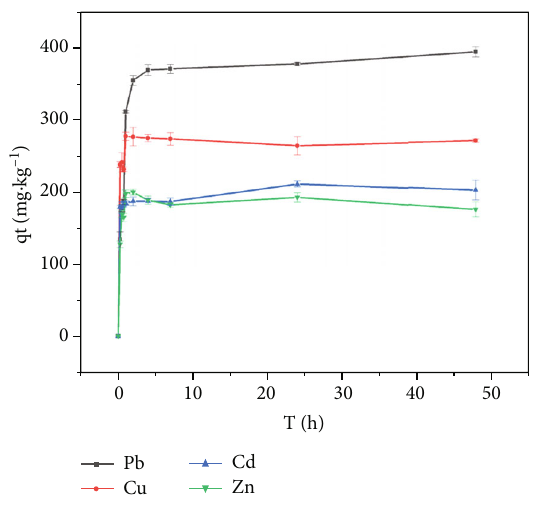
Figure 1: Adsorption curve of polypropylene microplastics ( C e = 0 : 7 mg · L -1 , V = 20 mL4, temperature at